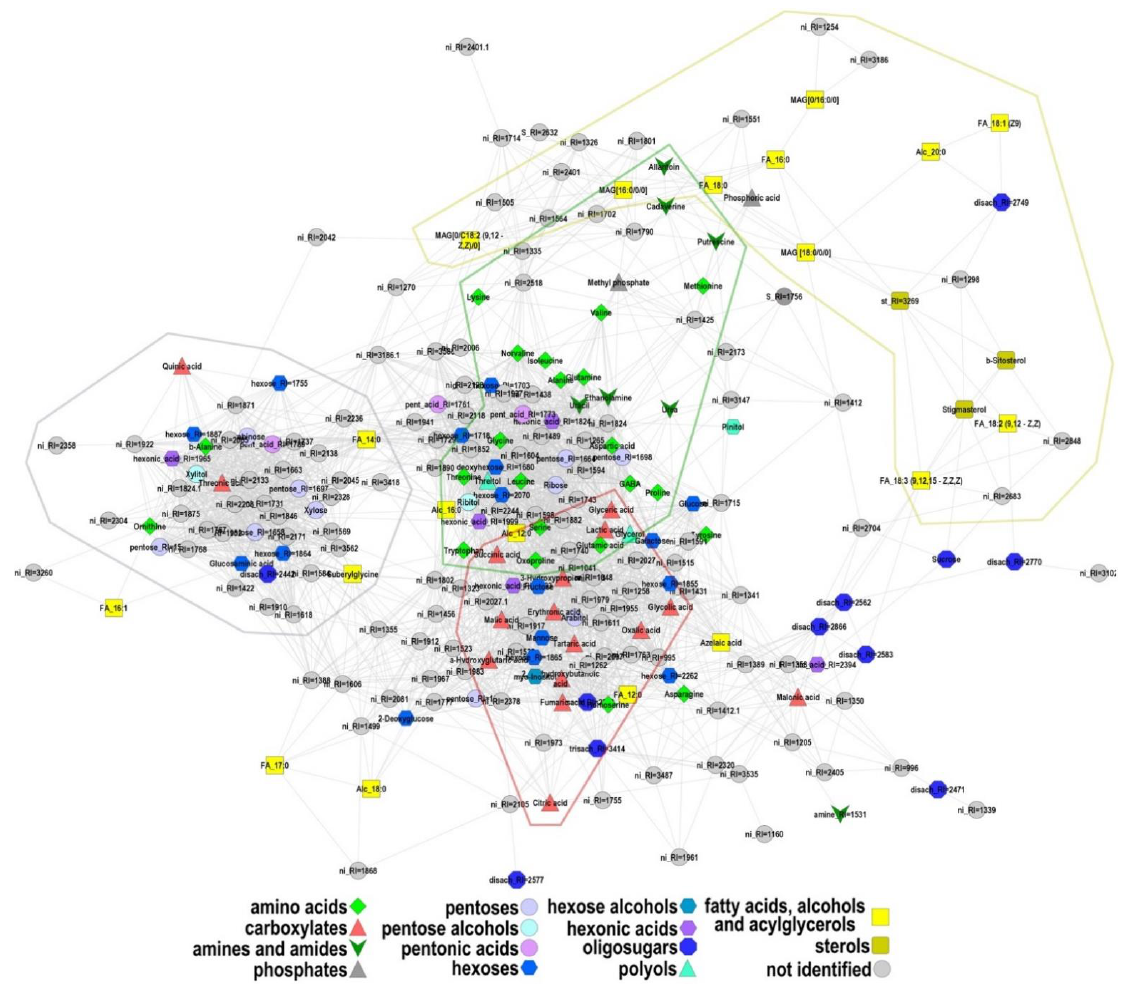
Figure 6. Mapping of metabolites by correlation of levels. Nodes correspond to metabolites, the shape and color reflect the chemical nature of the compound. Edges correspond to the strong Pearson correlations (r > 0.9) of the normalized average content in the variant (age-mycorrhization). Lines bound areas of related metabolites.